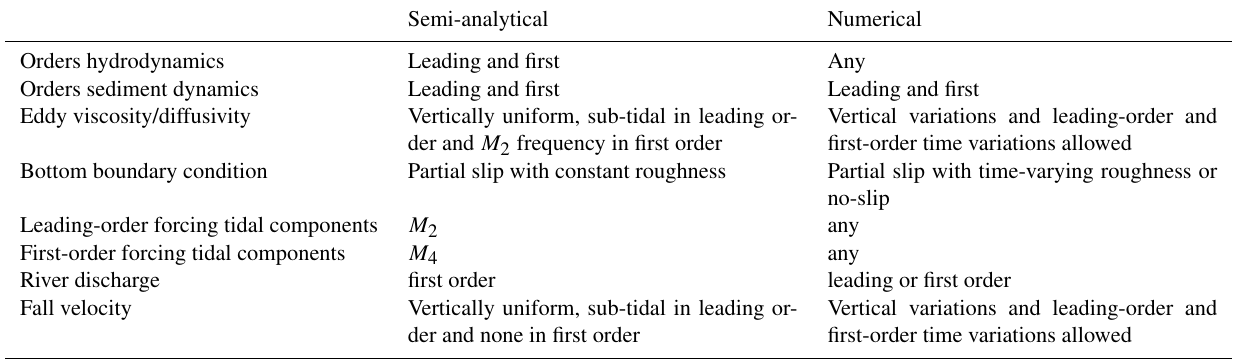
Table 3. Allowed forcing and turbulence options in the semi-analytical and numerical solution methods. Semi-analytical Numerical Orders hydrodynamics Leading and first Any Orders sediment dynamics Leading and first Leading and first Eddy viscosity/diffusivity Vertically uniform, sub-tidal in leading or- Vertical variations and leading-order and der and M 2 frequency in first order first-order time variations allowed Bottom boundary condition Partial slip with constant roughness Partial slip with time-varying roughness or no-slip Leading-order forcing tidal components M 2 any First-order forcing tidal components M 4 any River discharge first order leading or first order Fall velocity Vertically uniform, sub-tidal in leading or- Vertical variations and leading-order and der and none in first order first-order time variations